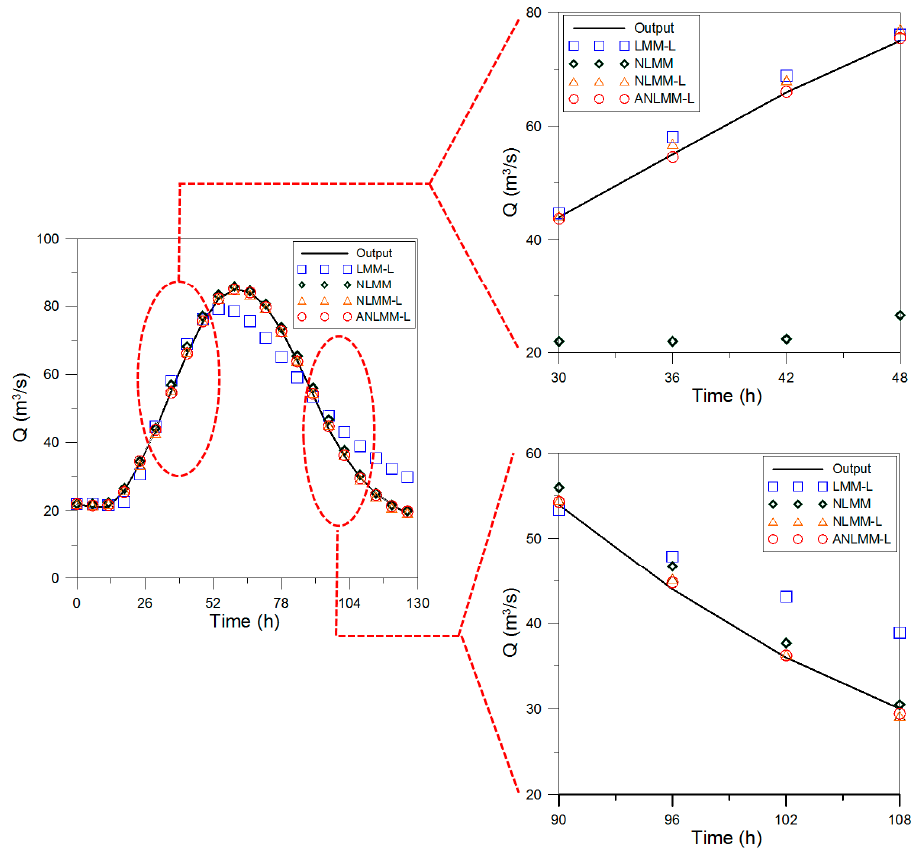
Figure 2. Comparison of results for the Wilson flood data.